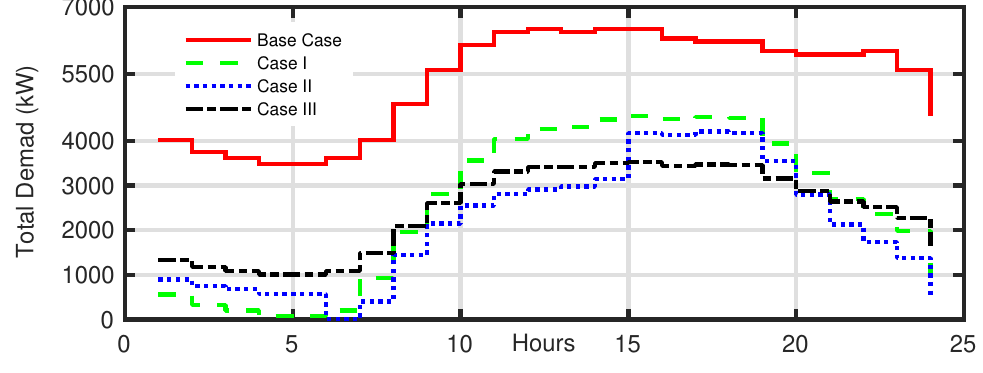
Figure 3. Mean node voltage profiles of 33-bus test distribution system.